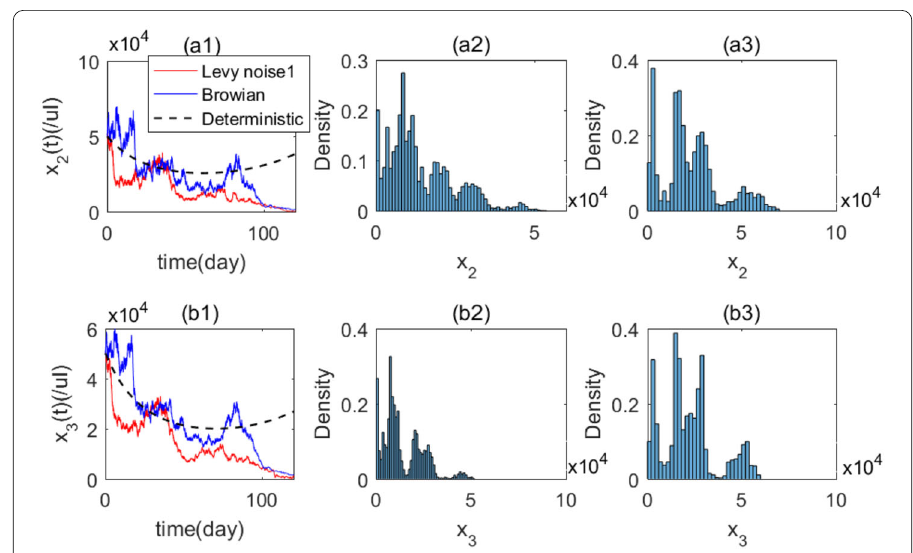
Figure 2 Numerical simulation of the path x 2 ( t ) and x 3 ( t ) for the deterministic model, the stochastic model with white noise, and the stochastic model with Lévy jump; The density functions of x 2 ( t ) and x 3 ( t ) are driven by Lévy noise and white noise, respectively. We apply an order 1 value ( x